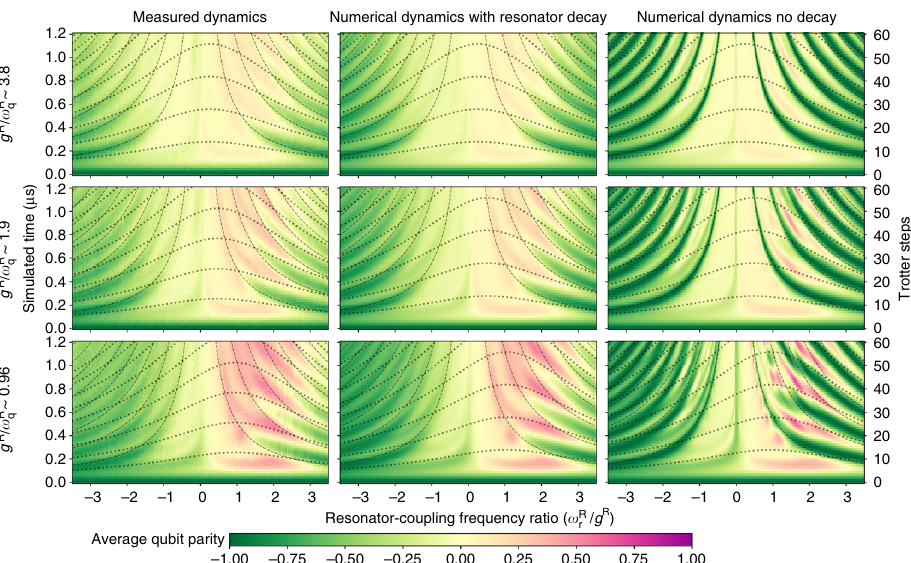
(cid:1) 4 (top), ∼ 2 Fig. 6 Measured and numerical quantum Rabi model qubit dynamics for nondegenerate qubit frequency. The cases implemented are g R = ω R q (middle) and ∼ 1 (bottom), with the plots showing measured qubit dynamics (left), numerically simulated dynamics of a Trotterised QRM with the measured T 1 ; r (cid:1) 3 : 5 μ s included (centre), and ideal Rabi dynamics (right). The results illustrate that the nondegenerate-qubit dynamics do not deviate (cid:9) ω R signi fi cantly from the degenerate-qubit case in the regime where ω R . The measured dynamics exhibit many qualitative features in good agreement r q with the ideal QRM and show excellent agreement with the numerical Trotter simulation with decay, indicating that the fi delity of the measured results to the ideal case is limited primarily by resonator